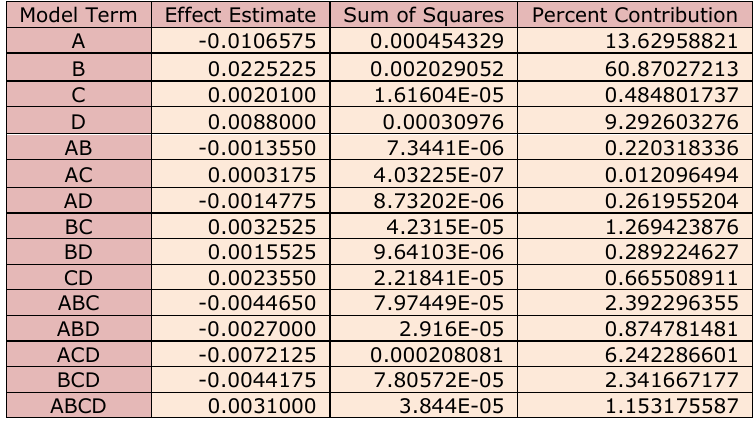
Table 5. Medication delivery error factor effect estimates and sums of squares